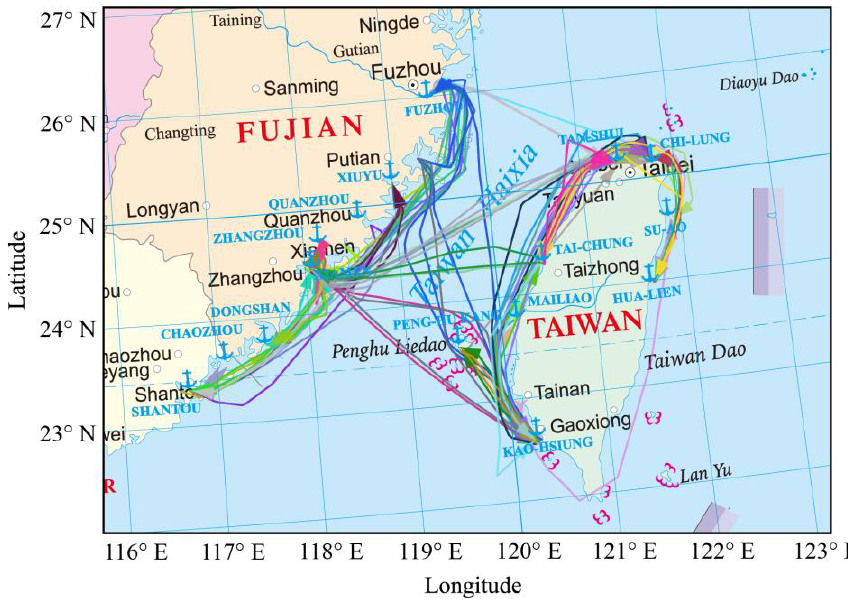
Figure 10. Extraction results of the ship navigation main routes in the Taiwan Strait.